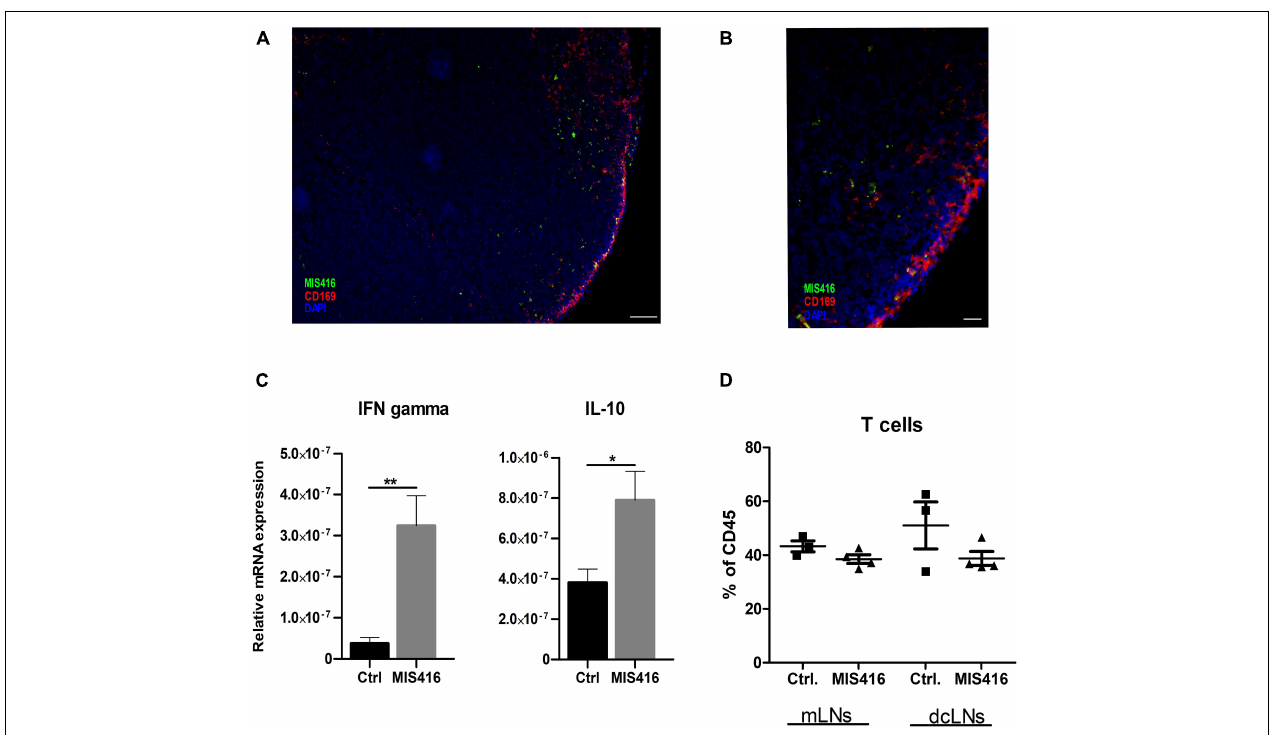
FIGURE 3 | Intrathecally administered fluorescent MIS416 can be detected in cervical draining lymph nodes where it promotes expression of IL-10 and IFN- γ . (A) Representative micrographs of mandibular LN from mice with focal EAE treated with intrathecal MIS146 showing colocalization of MIS416 (green) and nodal macrophages expressing CD169 (red); nuclei were stained with DAPI (blue). (B) Among cells positive for MIS416 (green) were nodal macrophages expressing CD169 (red). Nuclei were stained with DAPI (blue). Scale bar: A = 100 µ m, B = 20 µ m. (C) RT-qPCR analysis of IFN- γ and IL-10 expression in pooled mandibular and deep cervical LN collected 4 days post intrathecal injections of vehicle (Ctrl, n = 5) or MIS416 ( n = 7). (D) FC analysis on mandibular and deep cervical LN (day16) of vehicle (Ctrl, n = 3) and MIS416 treated mice ( n = 3). Data are presented as mean ± SEM. Results were analyzed using the two-tailed Mann-Whitney u -test; * p < 0.05, ** p <